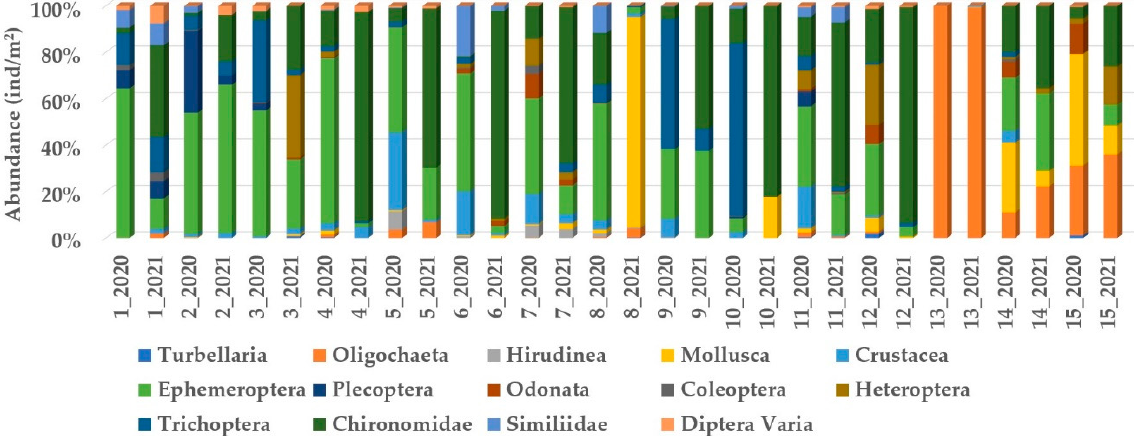
Figure 6. Percentage ratio of the abundance of the major taxonomic groups at the studied sites in 2020 and